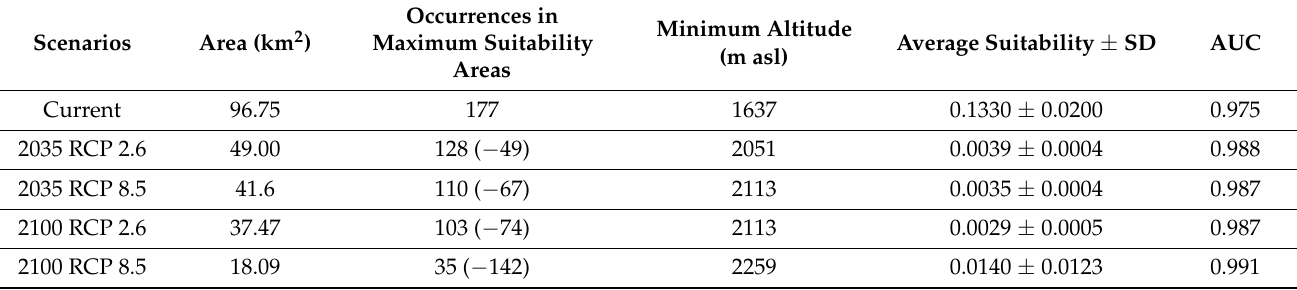
Figure 5. Reduction estimation of the maximum potential habitat suitability for Moehringia fontqueri . Temperature-based RCP 2.6 and precipitation-based RCP 8.5 scenarios for the years 2035 and 2100. Table 6. Area (km 2 ) occupied by the polygons of maximum current and future habitat suitability. Occurrences that would be found within each delimited area. Minimum altitude at which suitable habitat would be found for the species. Average suitability of the habitat in the subsequent polygons for each model ( ± standard deviation). AUC of each